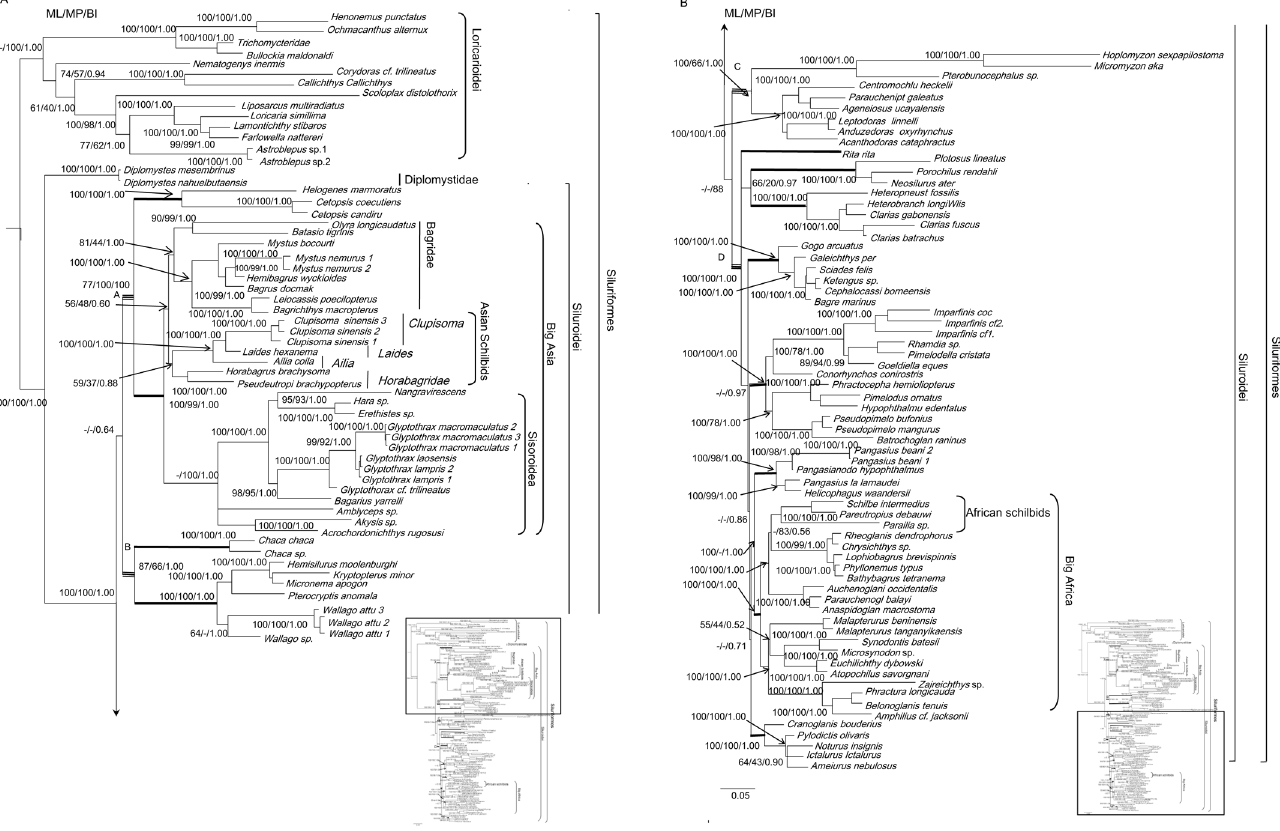
Fig 4. Phylogeny of catfishes based on a dataset expanded from Sullivan et al (2006) [8] with nodal support values for BI, ML, and MP, respectively. The 12 lineages marked by thick branches correspond with those revealed by Sullivan et al . (2006) [8]. (A) Part one of phylogeny of catfishes. The first two clades marked by A, B and ladder-like branch lines are newly resolved herein. (B) Part two of phylogeny of catfishes. Nodal support values are indicated on the branches. The last two clades marked by C, D and ladder-like branches are newly resolved